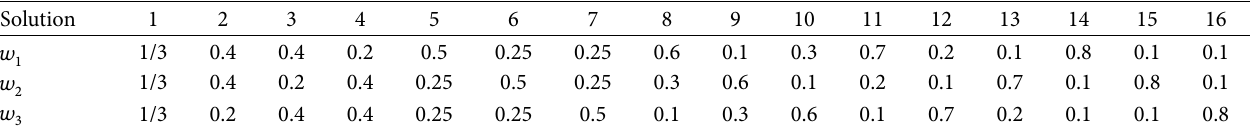
Table 6: 16 dispersed weight vectors.